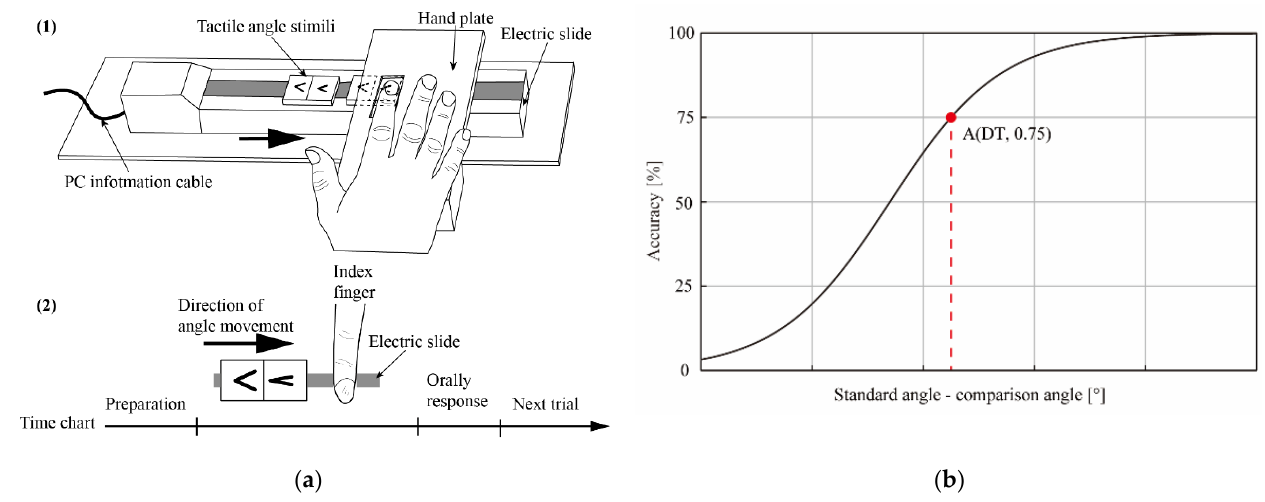
Figure 10. In the two-angle discrimination experiment, the instrument, the procedure and the DT of the calculation were used: ( a ) experiment method (1) the angle stimuli presentation instrument; (2) one trial procedure of angle discrimination and ( b ) the logistic function curve fitted from accuracy under an SA . The DT is the value with 75% accuracy.